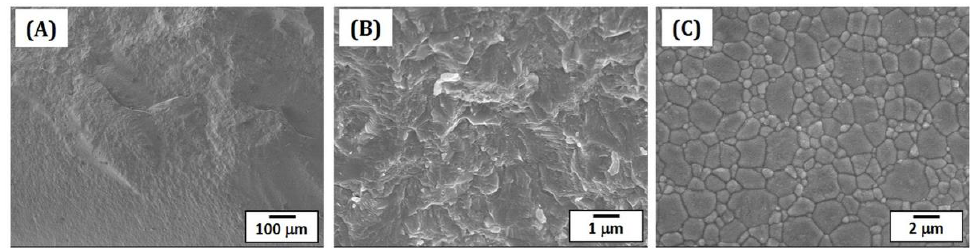
Figure 11. FE-SEM images showing fracture surfaces ( A , B ) and free surface of 5Y-PSZ disks after thermal etching at 1350 °C for 20 min ( C ).